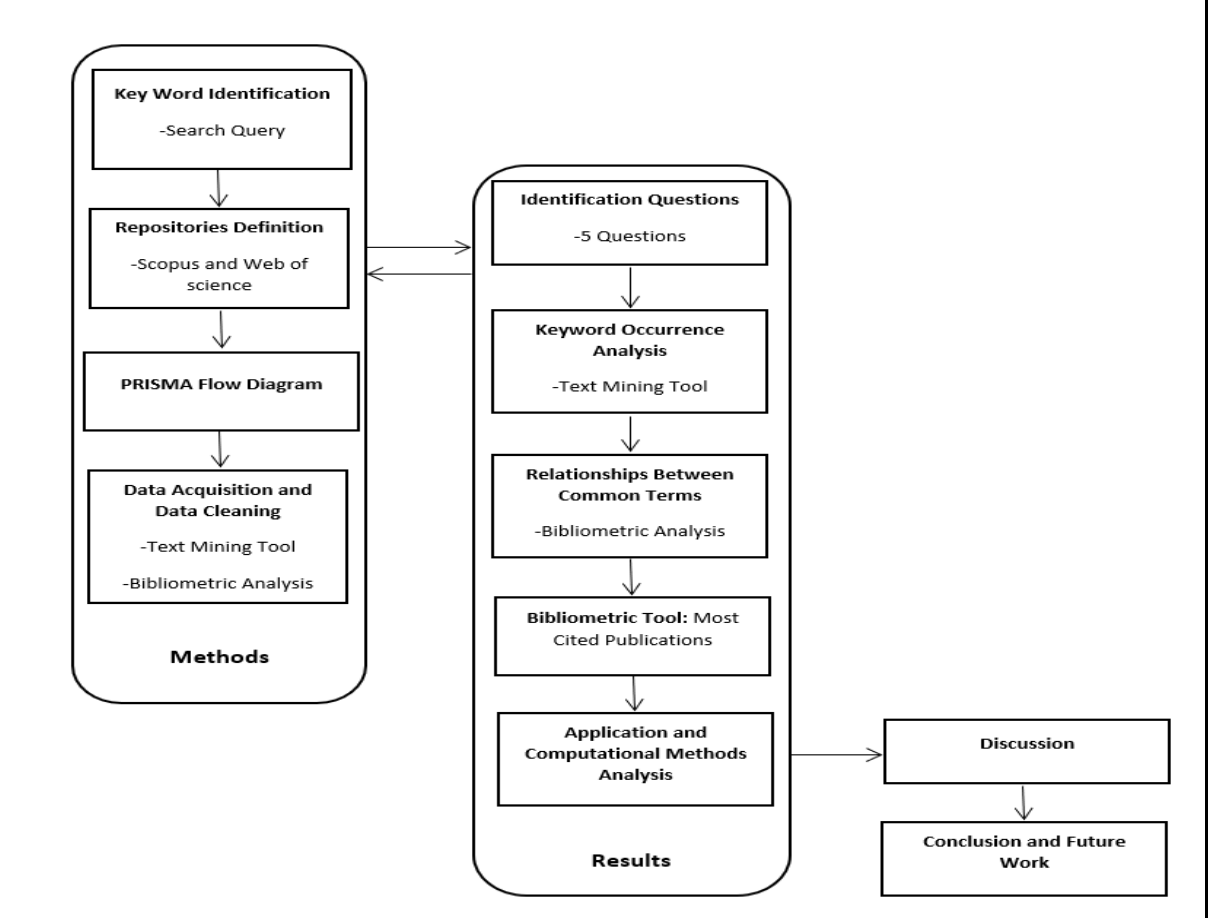
Figure 1. Methodology steps.